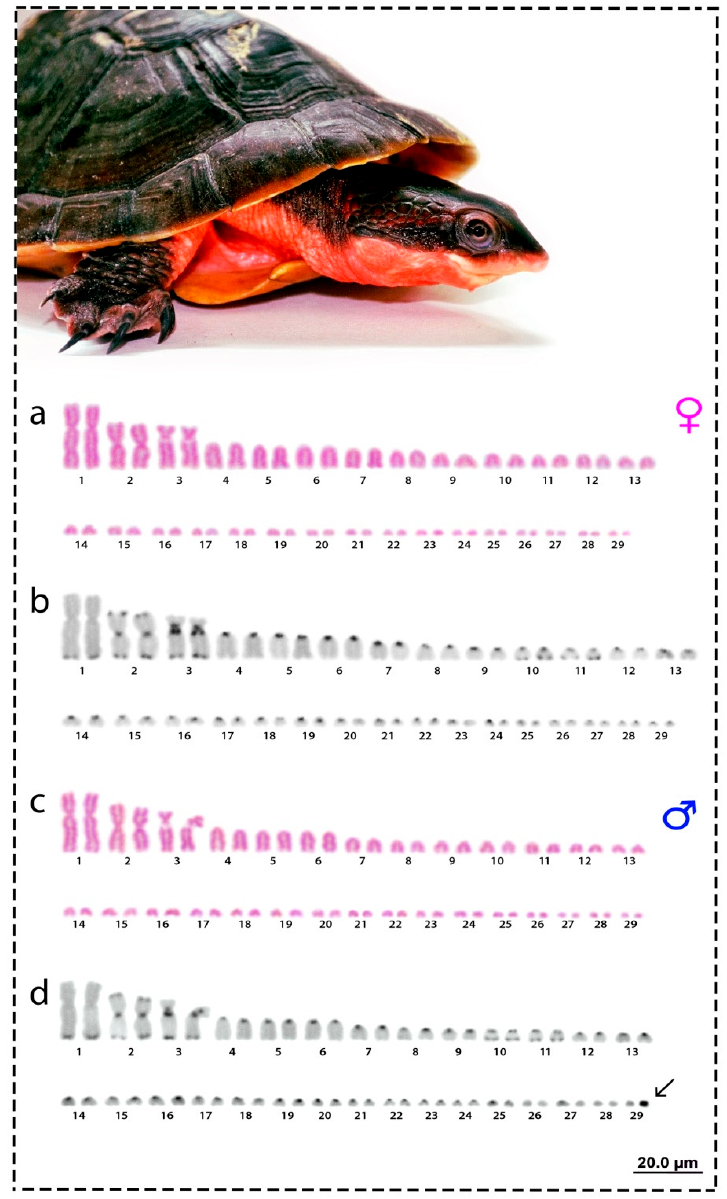
Figure 1. Karyotypes of females ( a , b ) and males ( c , d ) of R. rufipes in Giemsa-staining ( a , c ) and C-banding ( b , d ). Arrow indicates the tiny heterochromatic microchromosome, which corresponds to the Y sex chromosome. Bar = 20 µm.